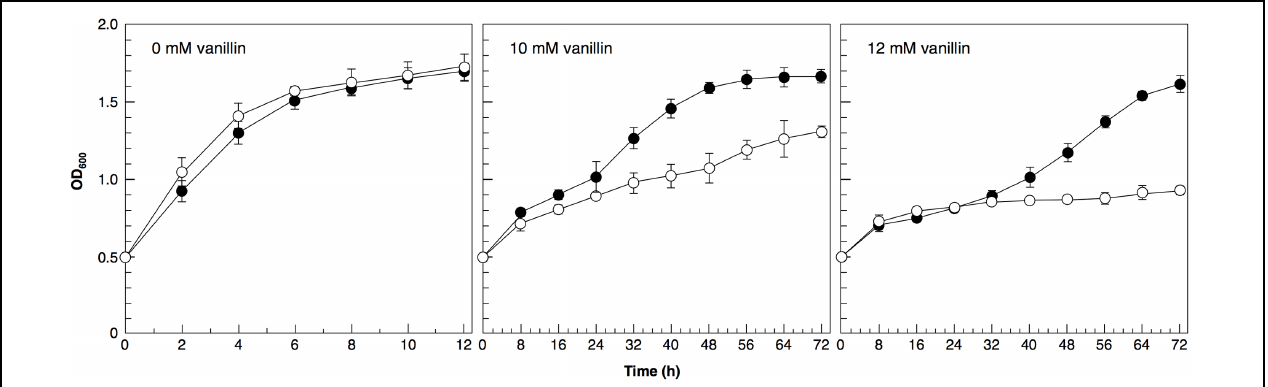
FIGURE 6 | Cells were cultured at 28 ◦ C in SD medium containing 10 or 12 mM vanillin. Cell growth was monitored by measuring the optical density at 600 nm (OD 600 ). Data are shown as the mean ± SD of three independent experiments. The strains examined were as follows: open circles, cells carrying pRS423; closed circles, cells carrying pRS423- ADH7 Pro - ADH6-ADH7 Ter .